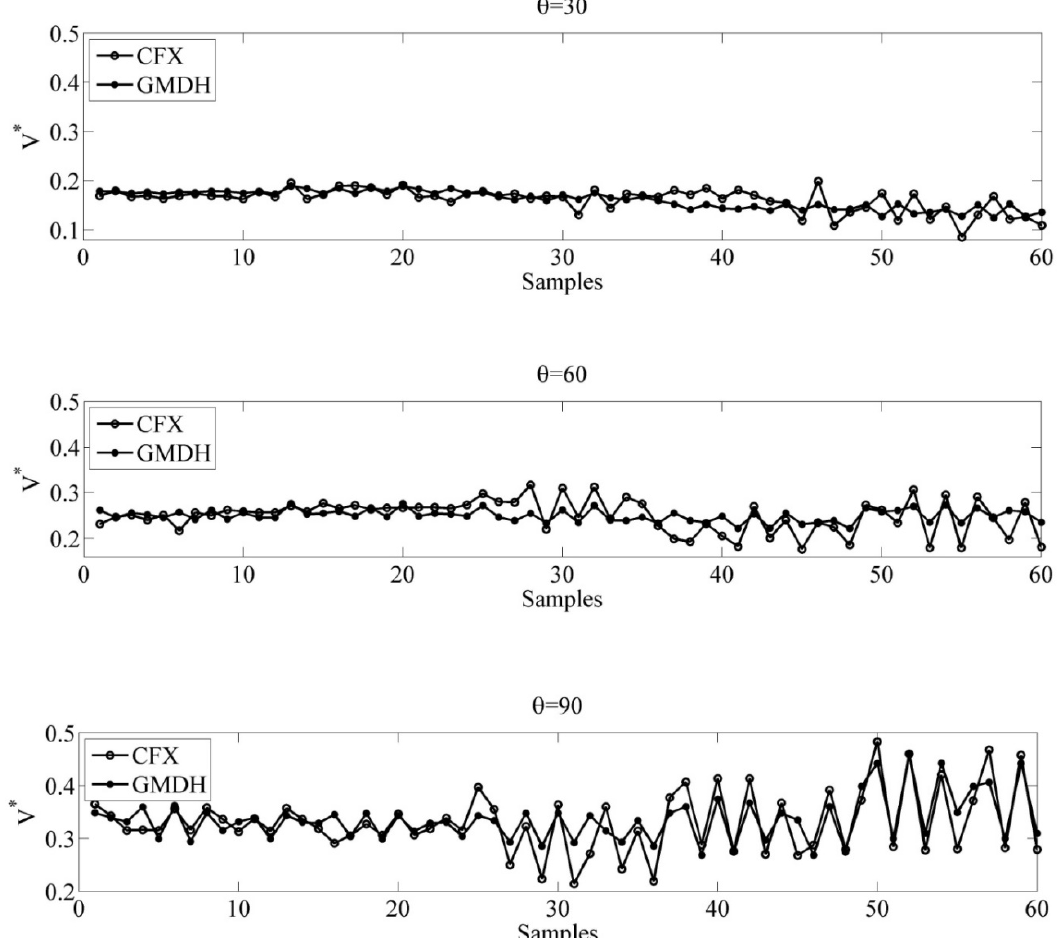
Figure 8. Performance of outcomes for testing phase of the GMDH model at different angles.